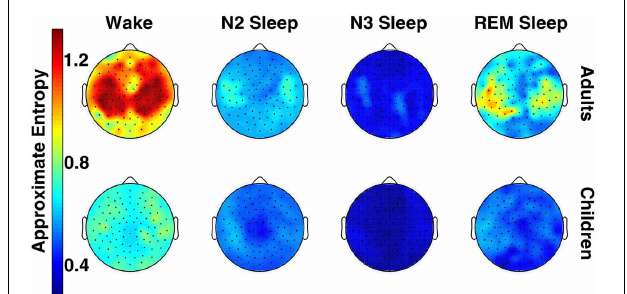
FIGURE 1 | Topography of across-subject mean ApEn values across vigilance state in adults and children (for both groups, n = 6).